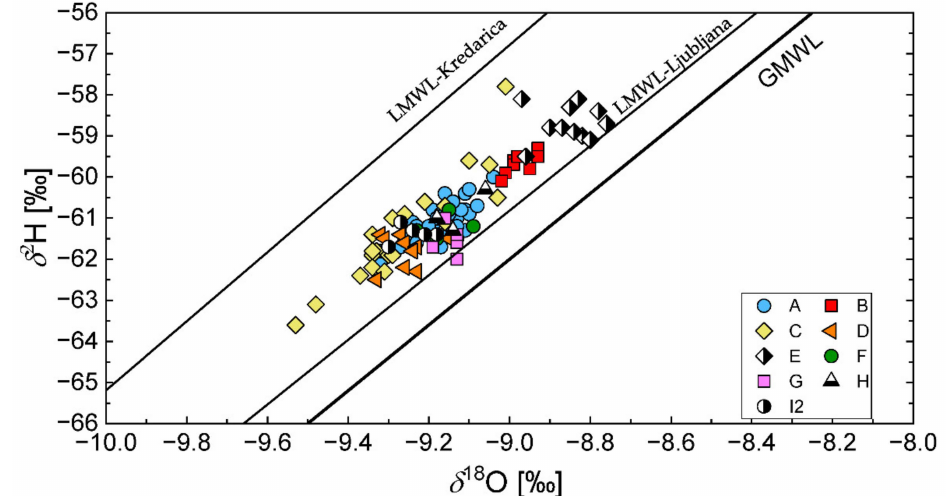
Figure 3. Dual isotope plot of the whole water supply system samples compared to the global meteoric water line (GMWL) and local meteoric water line (LMWL) from Ljubljana (2016–2018) and Kredarica (2016–2018). A = Kleˇce, B = Hrastje, C = Brest, D = Jarški prod, E = Šentvid, F = Hrastje/Jarški prod, G = Kleˇce/Brest, H = Kleˇce/Hrastje/Jarški prod and I2 = Kleˇce/Hrastje/Brest.